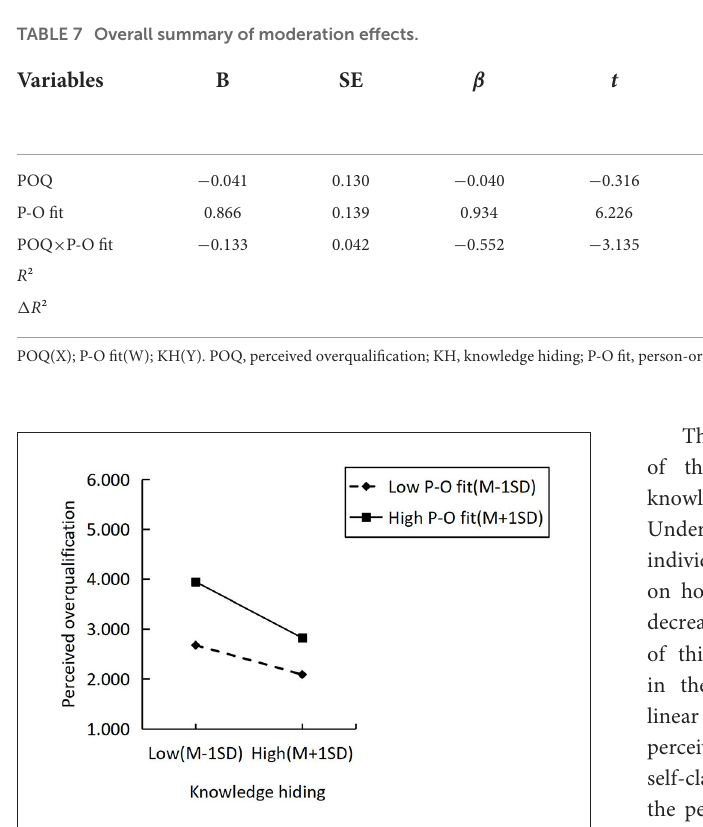
FIGURE2 Moderating effects and simple slope